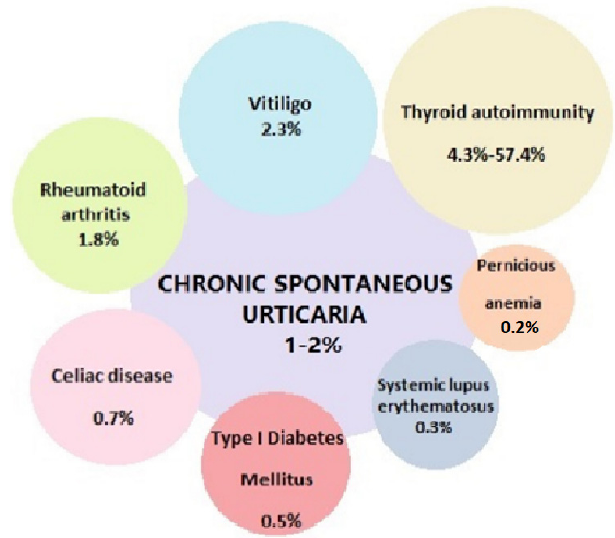
Figure 1. Prevalence of autoimmune diseases in CU.